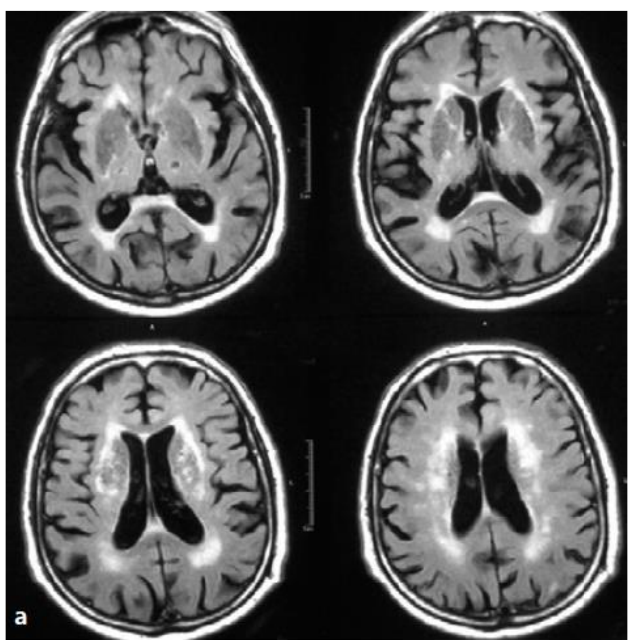
Figure 1. Brain MRI. Axial T2-weighted scans and fluid attenuation inversion recovery (FLAIR). Hypertension and recurrent strokes with subcortical lesions. Wide alteration of periventricular and lobar white matter signal. The image shows lacunar lesions involving thalami and internal capsules (lacunar state), together with the so-called “cribrose state”, with marked dilatation of base nuclei perivascular spaces. Table 1. Description of drugs administered to our patient. Inappropriate drugs are in bold (see explanation in the section discussion). Pantoprazole is reported in italics (see the section discussion).